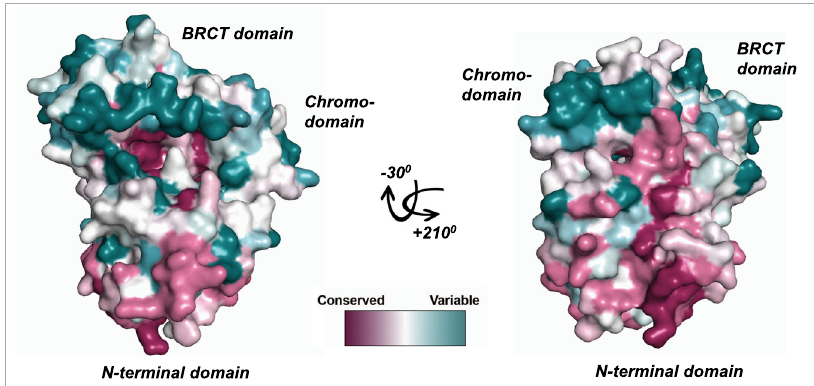
Fig. 2 Conservation analysis. Surface representation of the X-ray structure of the N-terminal module of BAF155 coloured by sequence conservation using the program ConSurf.